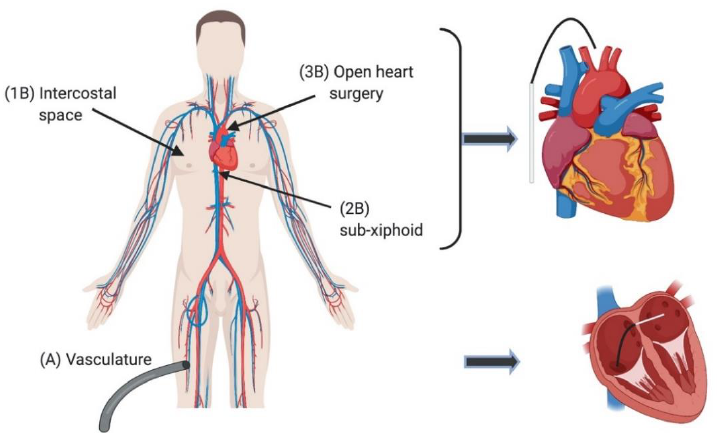
Figure 1. Access to the heart for invasive ablation purposes. This can be achieved via an internal endocardial approach ( A ) via the femoral vasculature (Table 1). Ablation catheter access can also be gained from an external epicardial (B) method. The extremities of the heart are reached by this technique. Access via an epicardial approach can be achieved through ports in the intercostal spaces ( 1B ), a sub-xiphoid puncture ( 2B ) or via open heart surgery ( 3B ). The choice made between the two approaches is often made in relation to the target area and patient’s disease substrate [10].